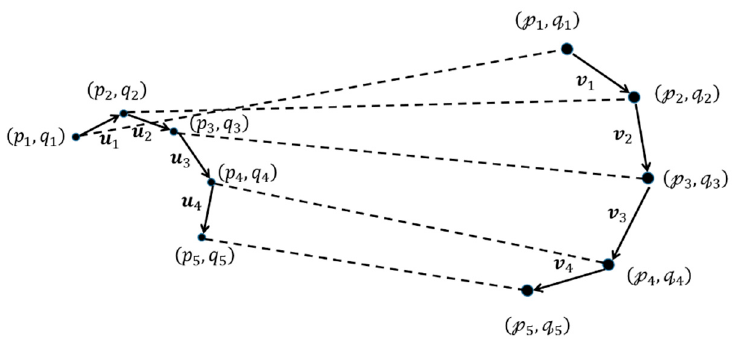
Figure 10. The shapes of the connected keypoints.